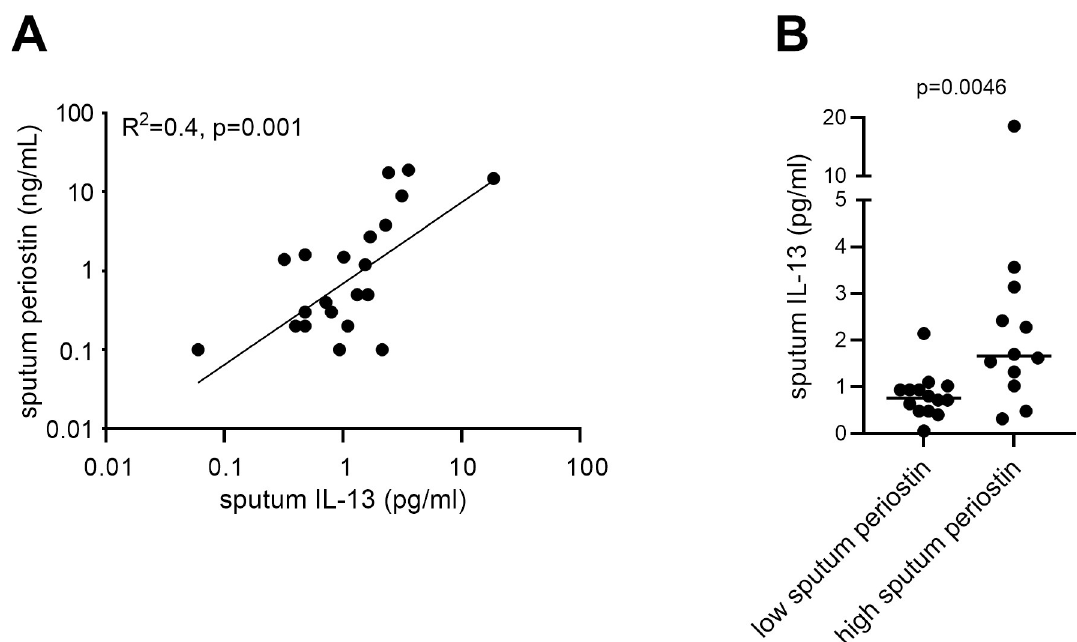
Fig 2. Association between sputum IL-13 and sputum periostin. The relationship between sputum IL-13 and sputum periostin (assay B) was examined in an additional, independent cohort of asthma patients. Panel A shows a scatterplot of sputum IL-13 and periostin levels analysed by linear regression (R 2 = 0.4, p = 0.0013). The Spearman r for this analysis was 0.59, p = 0.0031. Panel B shows sputum IL-13 levels in patients with sputum periostin < or � the group median, termed low sputum periostin and high sputum periostin. Individual data points are shown with line at group